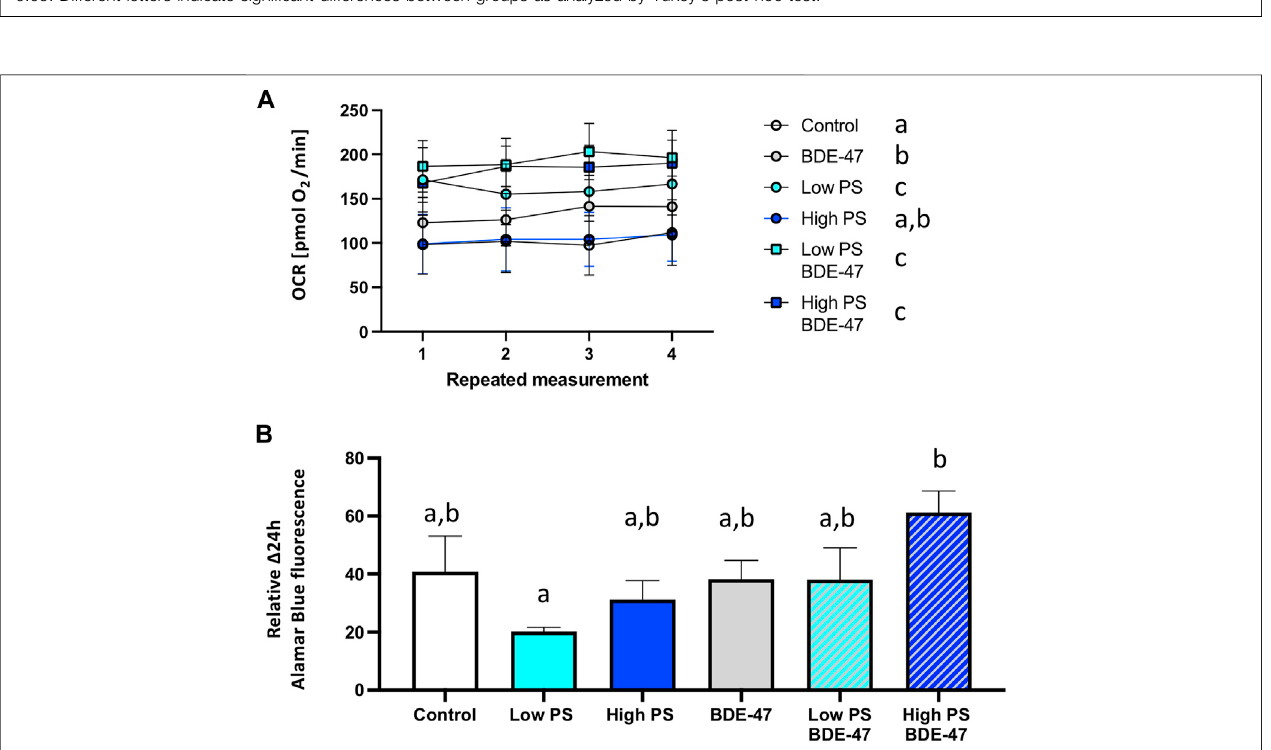
FIGURE 5 | Oxygen consumption rate (A) and 24 h oxygen metabolism-dependent energy expenditure of 2 dpf zebra fi sh eleutheroembryos exposed to vehicle control,2.5 ppm PS,25 ppm PS,10 pptBDE-47ortheircombinations (B) .Averageoxygenconsumptionrates+S.E.M.from n =3replicateassaysforeachgroupwith acombined n =7 – 9pertreatmentgrouparepresented (A) .Averagerepeatedmeasurementsof24 hoxygenmetabolism-dependentenergyexpenditures+S.E.M.from n = 3 replicate assays for each group with an n = 33 – 47 per treatment group are presented (B) . Data were analyzed using a one-way repeated measurement ANOVA (A) andone-wayANOVA (B) measurementwithasigni fi cancecut-offof p < 0.05.Differentlettersindicatesigni fi cantdifferencesbetweengroupsasanalyzedby Tukey ’ s post-hoc test.